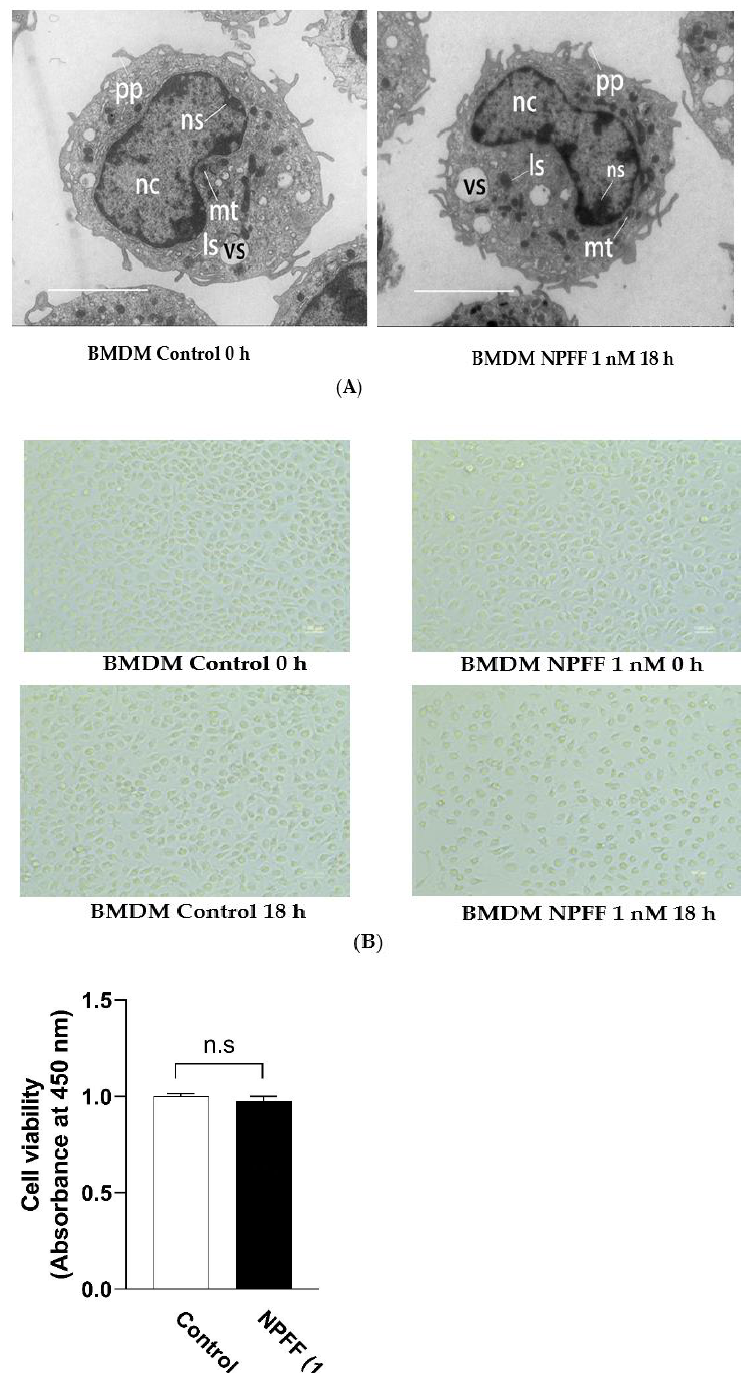
Figure 2. The effect of NPFF treatment on BMDMs. BMDMs were treated with or without NPFF (1 nM) for 18 h, followed by various examinations. ( A ) The detailed structure of the cells was ob- tained by electron microscopy. Scale bar, 50 μm. Nc = nucleus; ns = nucleolus; mt = mitochondria; vs = vesicle; ls = lysosome; pp = pseudopodia. ( B ) The morphology of the cells was acquired by optical microscope inspection. Scale bar, 100 μm. ( C ) The cell viability was investigated by CCK-8 assay. N.s, no significance. Each test was performed four times in duplicate. The data were shown as the means ± S.E.M. Statistical significance analysis was carried out using the t-test method.